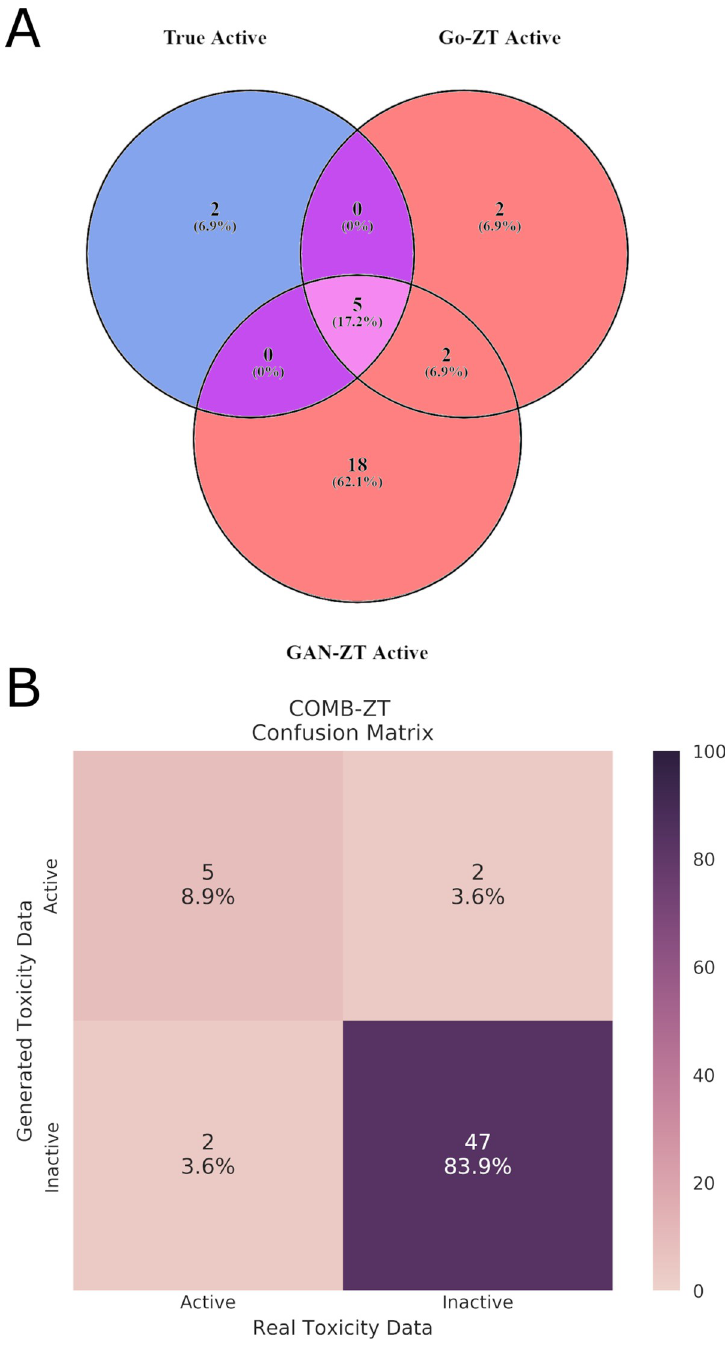
Fig 8. Model consensus on chemical activity. (A)Venn diagram showing the overlap between true active chemicals and chemicals predicted to be active by either Go-ZT or GAN-ZT. (B) A confusion matrix showing the performance of the combined Go-ZT and GAN-ZT models using the test